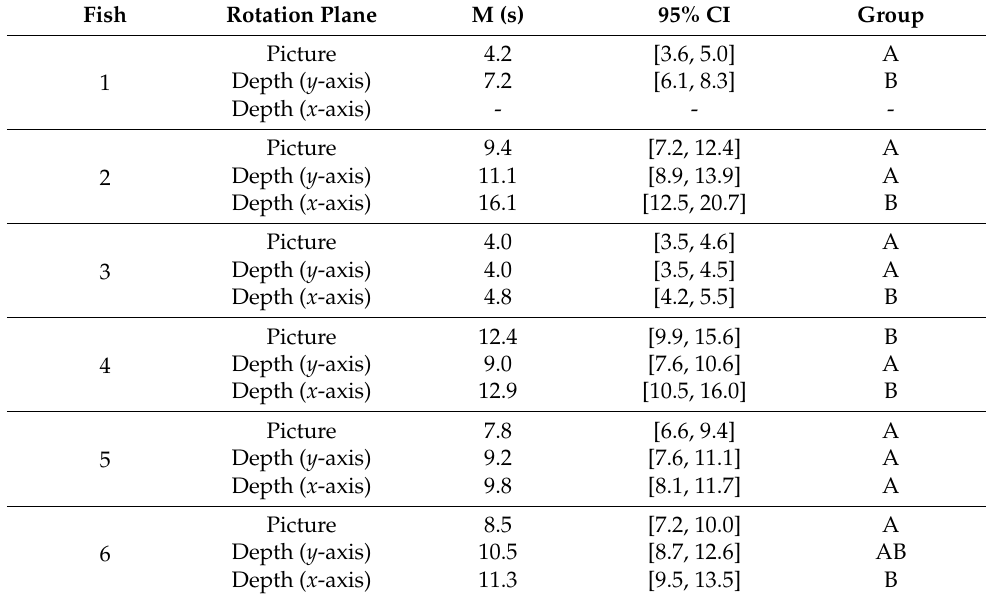
Table 5. Trial time in testing for all fish and rotation planes.